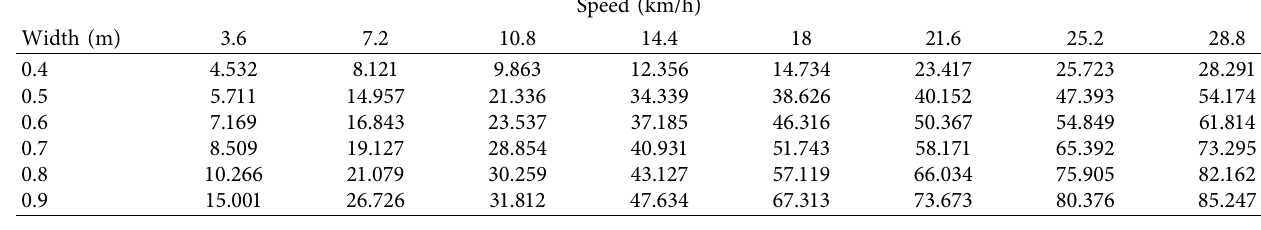
Table 10: Simulation results of the maximum peak value of the vertical acceleration at the driver’s seat when vehicle crossing a vertical wall (m/s 2 ). Width (m)